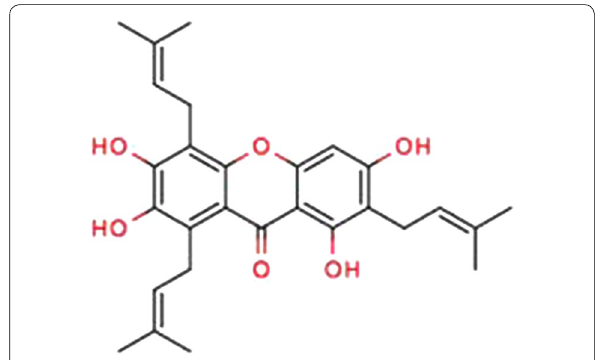
Fig. 1 Chemical structure of garcinone-E